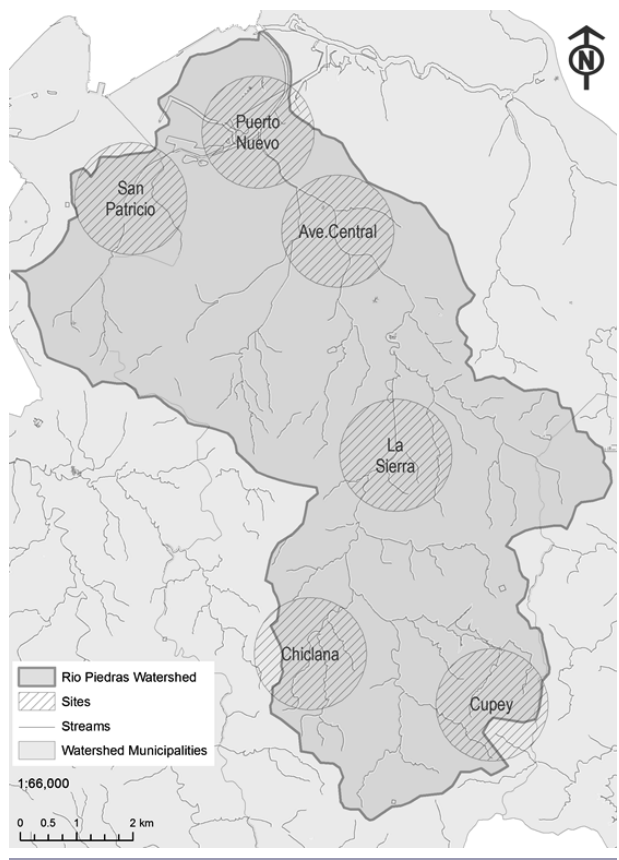
Fig. 1 . Six monitoring sites across the Río Piedras watershed in the San Juan metropolitan area of Puerto